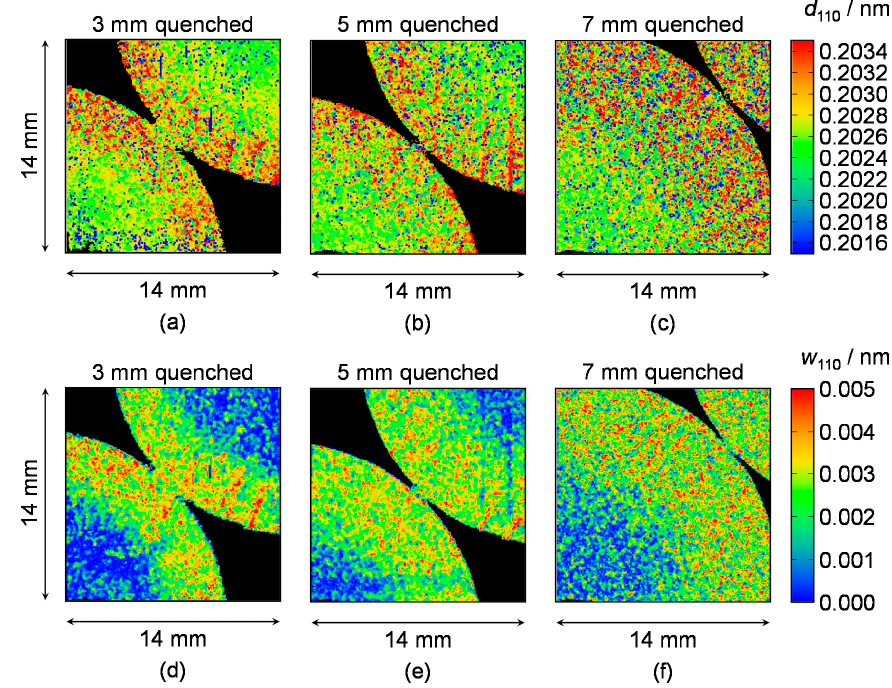
Figure 13. ( a – c ) Images of crystal lattice plane spacing ( d -spacing) of {110} [6]. ( d – f ) Images of